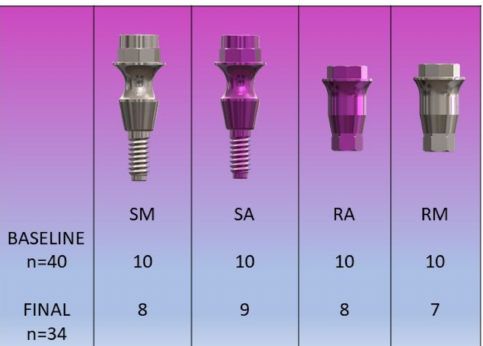
Figure 1. Group distribution. Abutment design: SM (slim machined), SA (slim anodized), RA (regular anodized), RM (regular